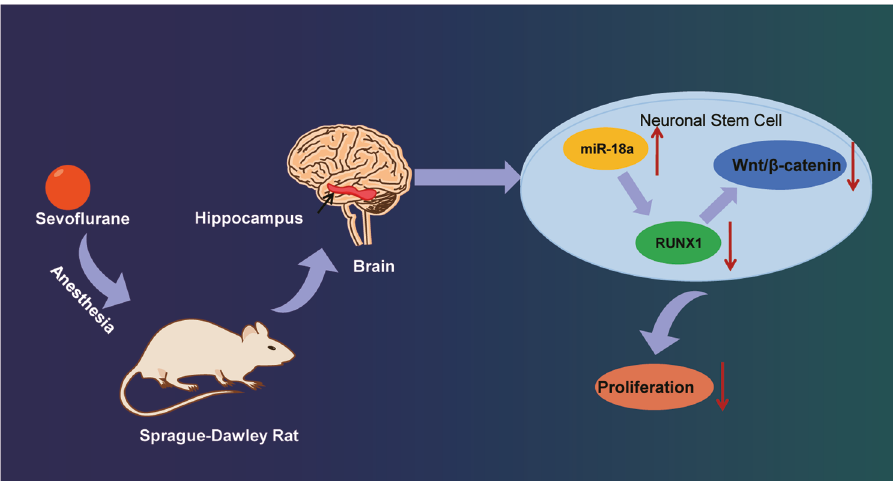
Fig. 6 Schematic diagram of the molecular mechanism by which sevo fl urane inactivated the RUNX1/Wnt/ β -catenin signaling pathway through miR-18a upregulation to regulate NSC proliferation in 9-day-old neonatal rats. Sevo fl urane inactivates the RUNX1/Wnt/ β -catenin signaling pathway by inducing miR-18a expression, whereby inhibiting NSC proliferation and affecting rat